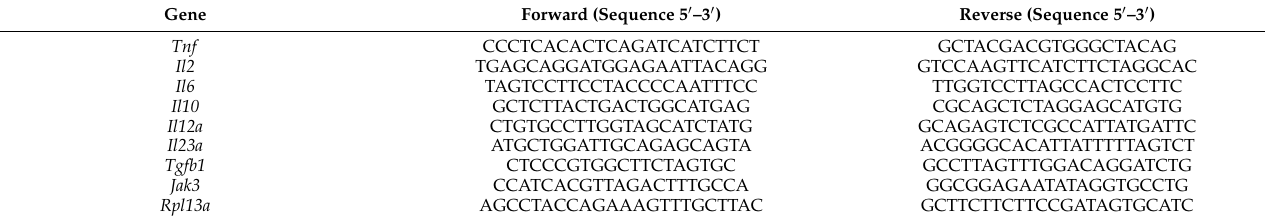
Table 1. Sequences of primers of inflammatory cytokines quantified by